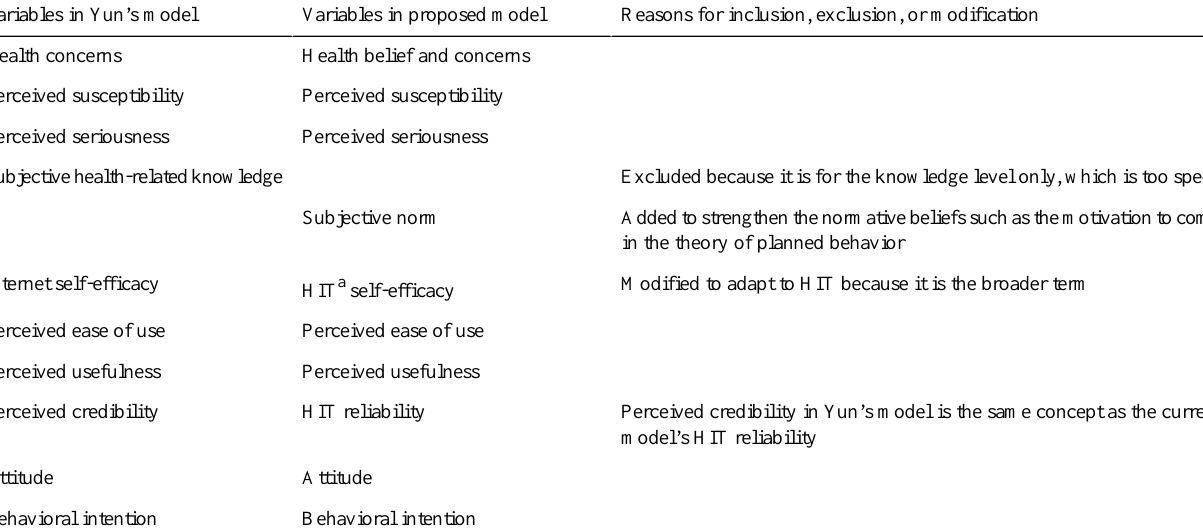
Table 1. Comparison of variables in Yun [14] and the present study.